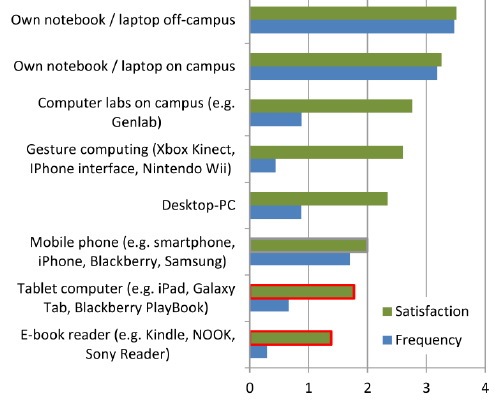
Figure 6. Means of students’ responses to the